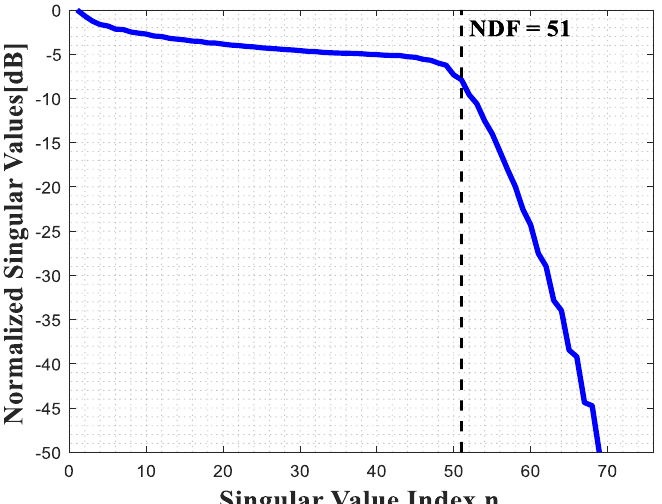
Figure 10. The normalized singular values of the linearized inverse scattering operator for the cir- cumference arc case.